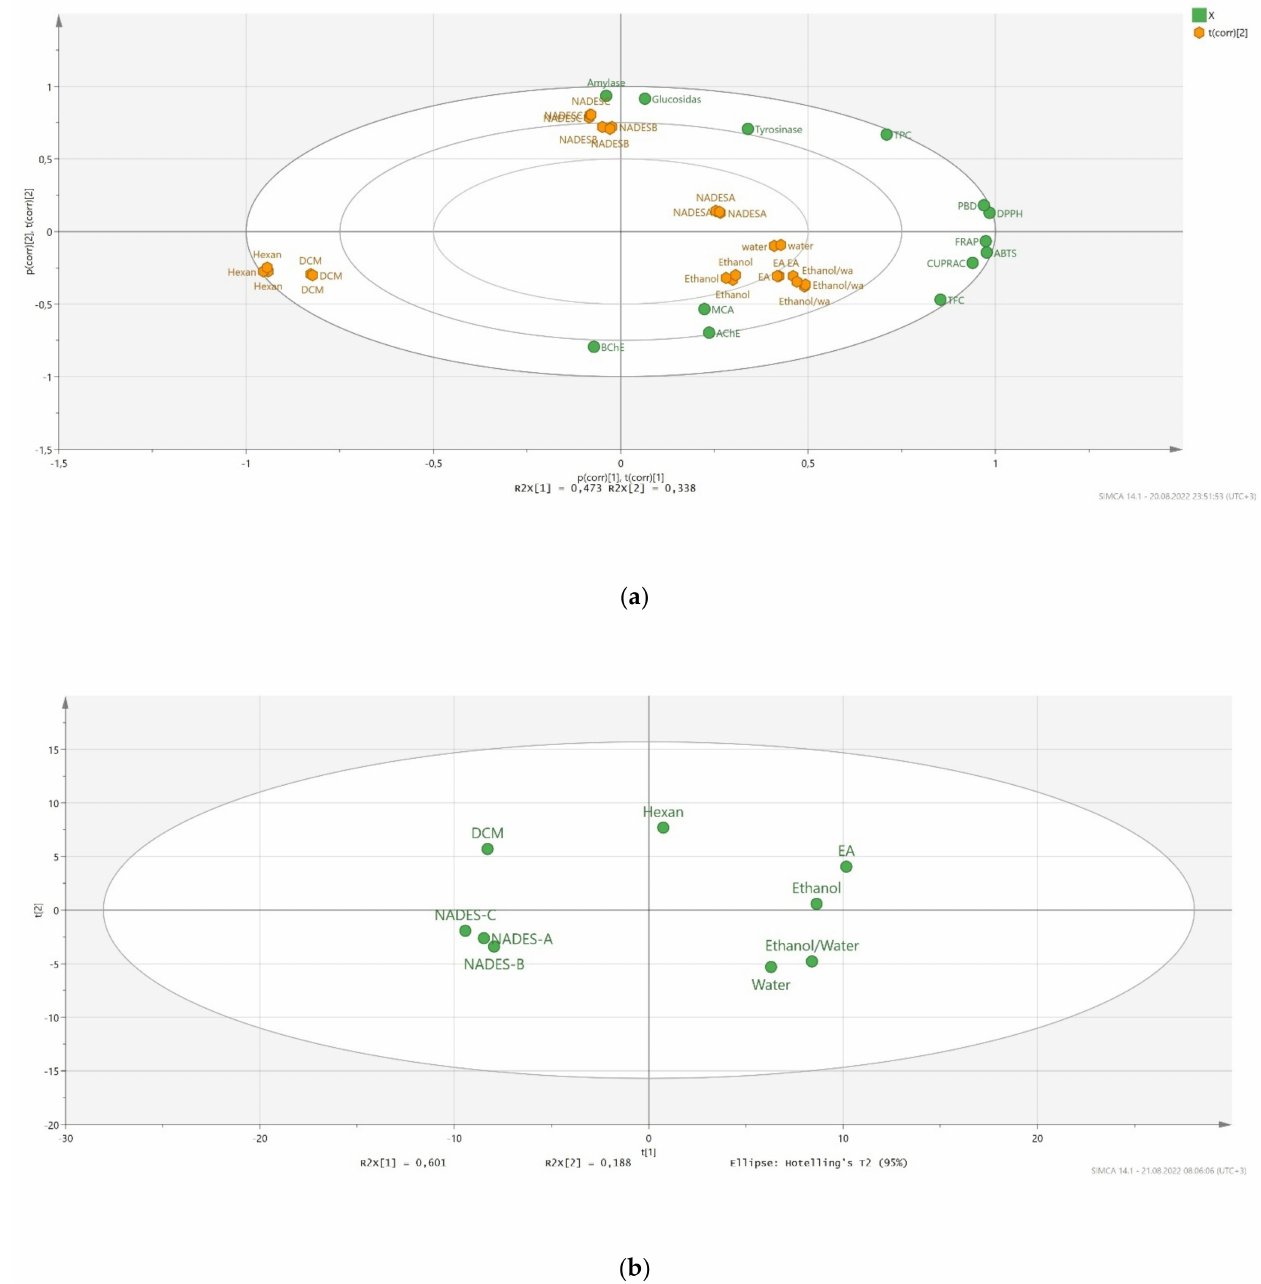
Figure 4. Principal component analysis between tested extracts and biological activities ( a ). Distri- bution of the tested extracts in principal component analysis by using chemical compound peak areas ( b